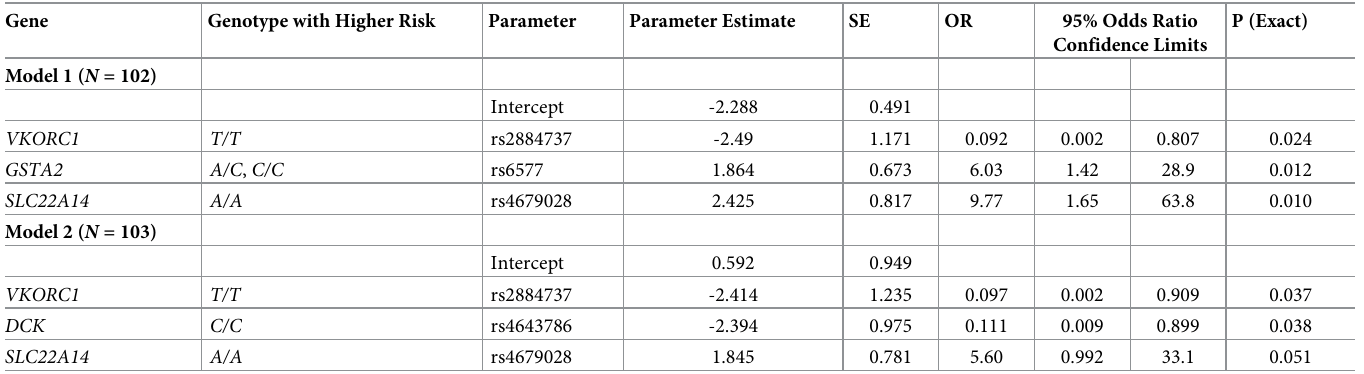
Table 4. Logistic regression models of